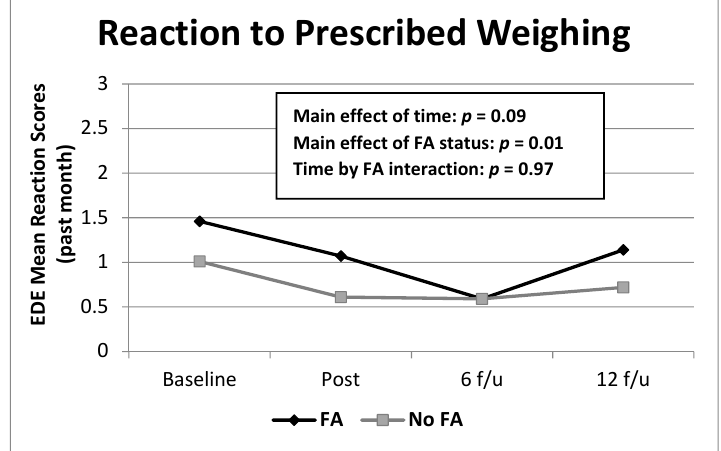
Figure 1. Frequencies of EDE Reaction to prescribed Weighing scores over time by food addiction group. Note: Means were derived from raw data for ease of interpretation. EDE = Eating Disorder Examination; FA = food addiction. Reaction = reaction to prescribed weighing during the past 28 days. Significant main effects were found for food addiction across all time points ( p < 0.01).